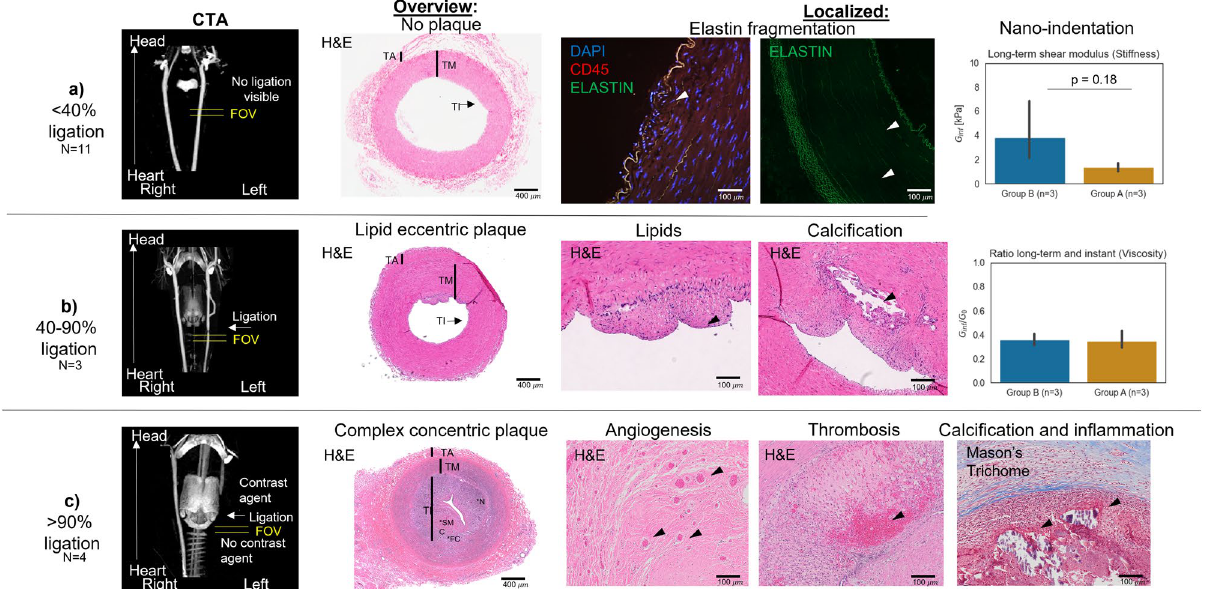
(7.51 ± 7.42 × 10 −11 m 2 Pa −1 and 6.56 ± 6.04 × 10 −10 m 2 Pa −1 ). Fig. 7 reveals the ex-vivo quantification of the carotids of the three groups. Group C, with the most compliant carotids, showed complex plaque features such as angiogenesis, thrombosis, minor calcification, and inflam- mation. Group B showed some minor lipid depositions and some features of a complex plaque, but less than group C. Both groups A and B showed signs of elastin fragmentation. Additionally, nanoindentation indicated a non-significant ( p =0.18, paired t test) increase in mean long-term shear moduli for group B (n=3) compared with group A (n=3). The mean long-term shear moduli for the three carotids of Group B is 3.80 ± 2.62 kPa and the mean long-term shear moduli for the three carotids of Group A is 1.36 ± 0.33 kPa. The ratio of the long-term